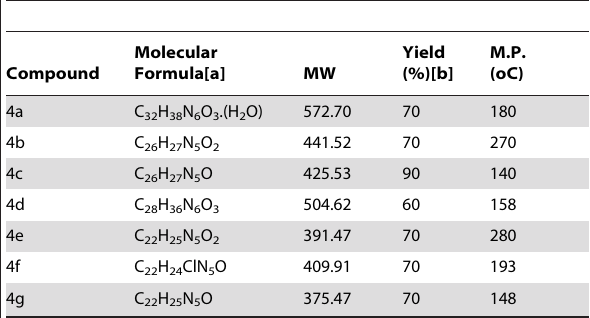
Table 1. Yields and physical properties of N -phenyl-pyrazolyl- N -glycinyl-hydrazone derivatives 4a-g.